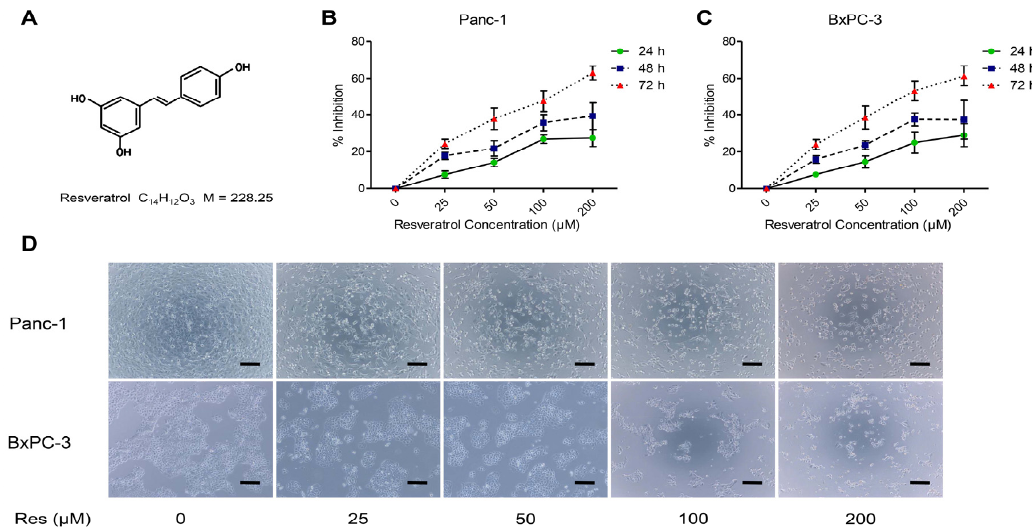
Figure 1. Resveratrol inhibits the proliferation of pancreatic cancer cells. ( A ) The structure of resveratrol (Res); ( B , C ) Panc ‐ 1 and BxPC ‐ 3 pancreatic cancer cells were treated with increasing concentrations of resveratrol (0, 25, 50, 100, and 200 μ M) for 24 h, 48 h, or 72 h to analyze the inhibition ratio for cancer cell proliferation; ( D ) Micrographs of Panc ‐ 1 and BxPC ‐ 3 cells after being treated with the indicated concentrations of resveratrol for 48 h; representative images were captured (magnification, 100×; Scar bar: 100 μ m).